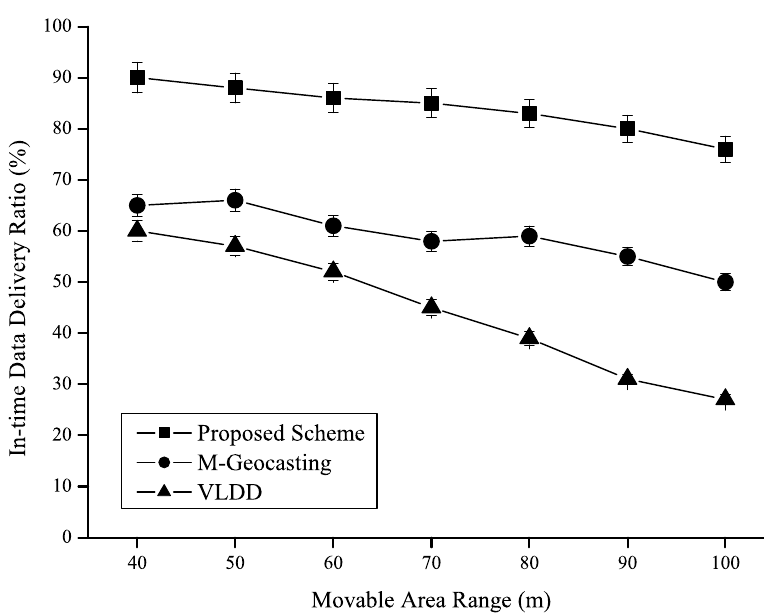
Figure 7. Comparison of in-time data delivery ratio according to movable area range.